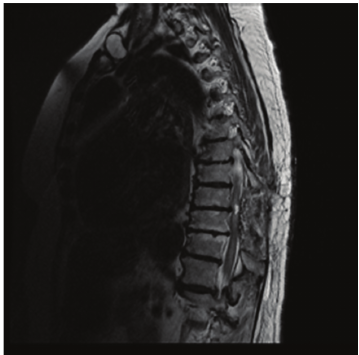
Figure 2: Postoperative sagittal thoracic MRI demonstrated total resection of